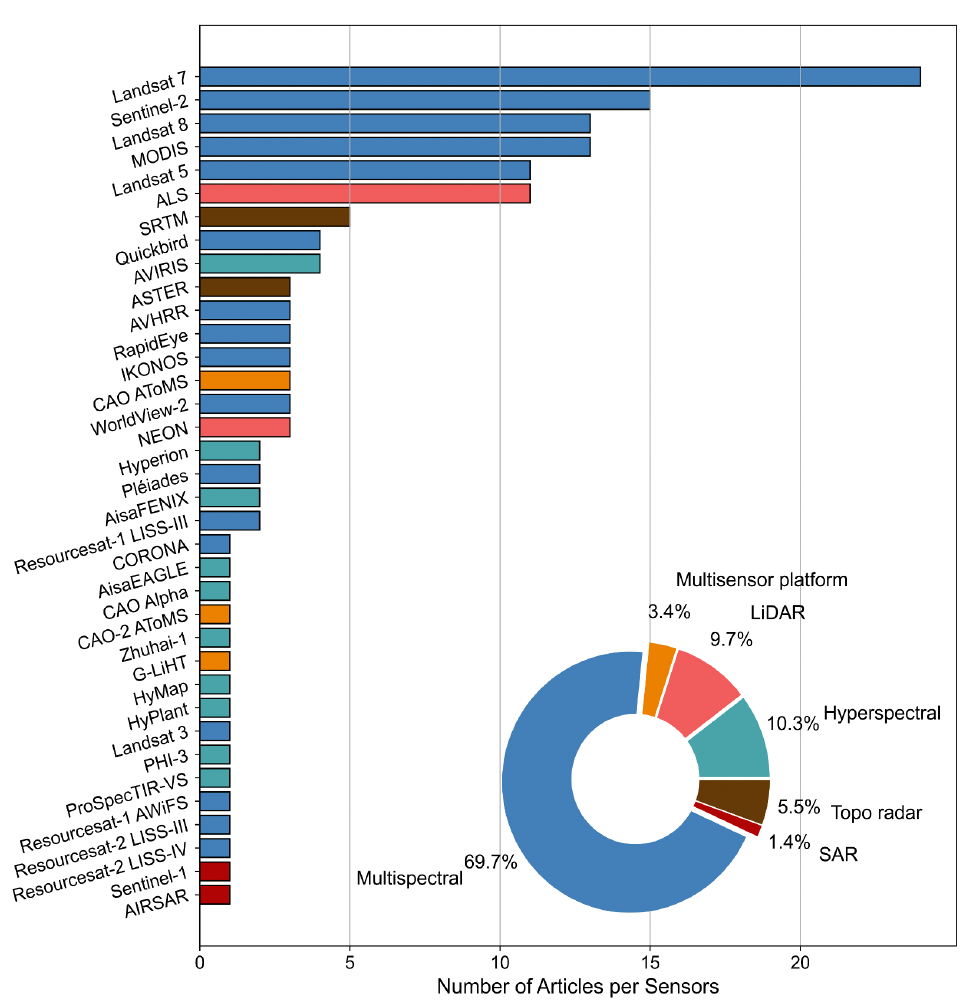
Figure 7. Overview of the different remote sensing sensors used in the reviewed articles. A strong dominance of multispectral sensors (about 70% of all integrated sensors) is emphasized by the fact that sensors from the Landsat mission contribute by about 34% to the total number of sensors used ( n = 145). Abbreviations: AIRSAR = Airborne Synthetic Aperture Radar; ALS = Airborne Laser Scan- ning; ASTER = Advanced Spaceborne Thermal Emission and Reflection Radiometer; AVHRR = Ad- vanced Very High Resolution Radiometer; AVIRIS = Airborne Visible/Infrared Imaging Spectrometer; CAO = Carnegie Airborne Observatory; G-LiHT = Goddard’s LiDAR, Hyperspectral & Thermal Imager; MODIS = Moderate-resolution Imaging Spectroradiometer; SRTM = Shuttle Radar Topogra- phy